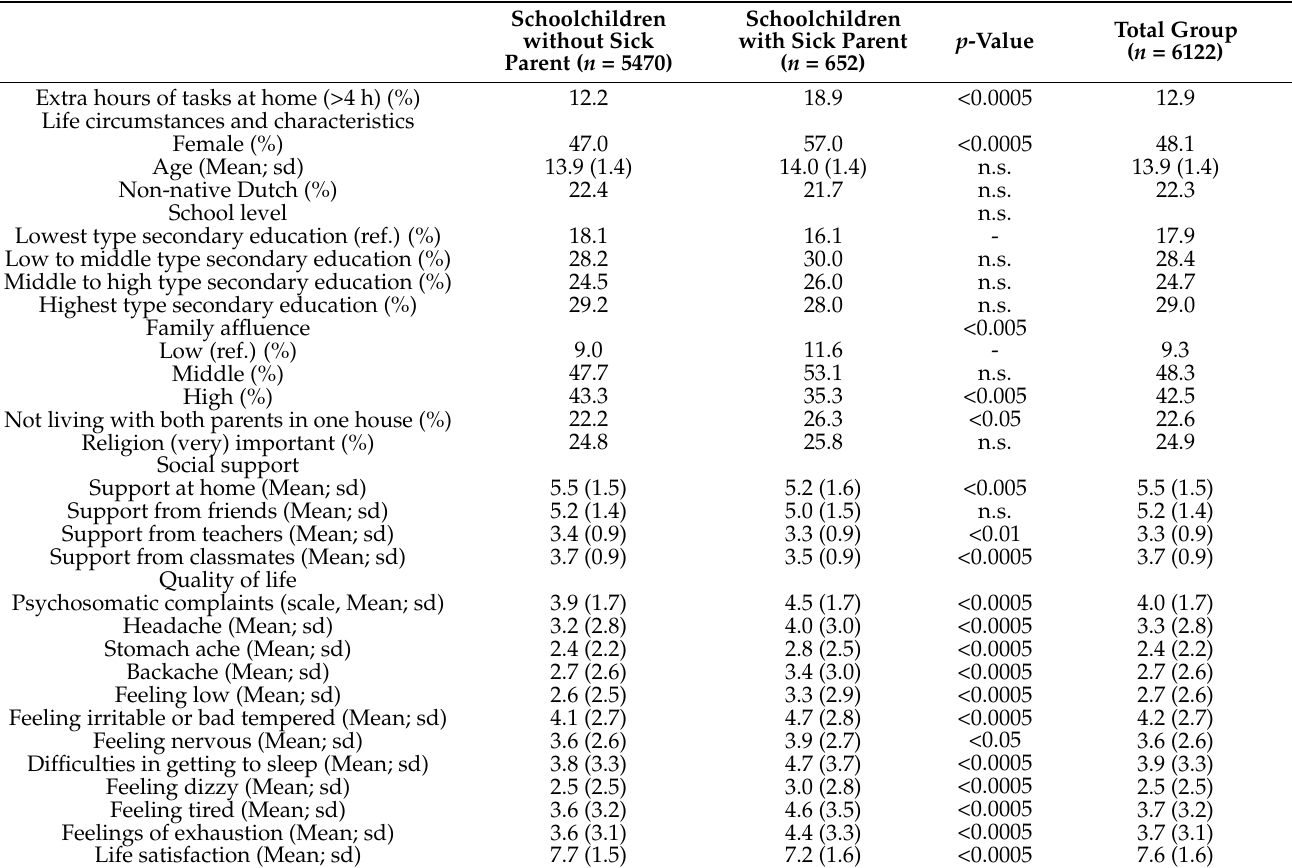
Table 1. Description of the extra hours of tasks at home, life circumstances and characteristics, support, and quality of life of schoolchildren (aged between 12 and 16) without and with a chronically sick parent—tested for significant differences in the column p -Value—and of the total study population ( n = 6122). Schoolchildren without Sick Parent ( n =